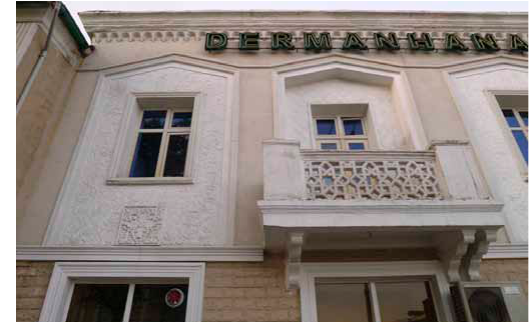
fig. 20. The motive of cornflowers in the socialist realism architecture of Minsk. r. Čepaitienė photo